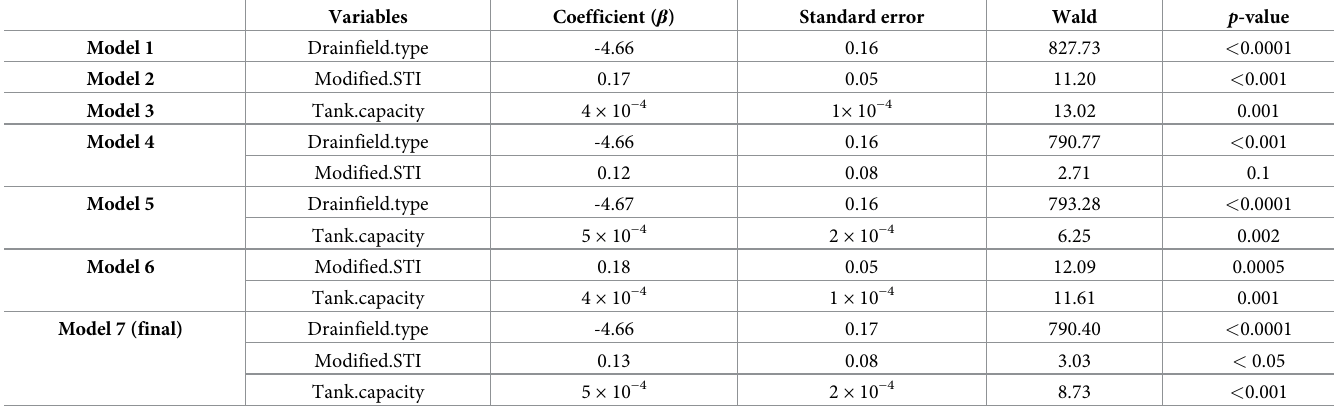
The p -value < 0.05 is significant.